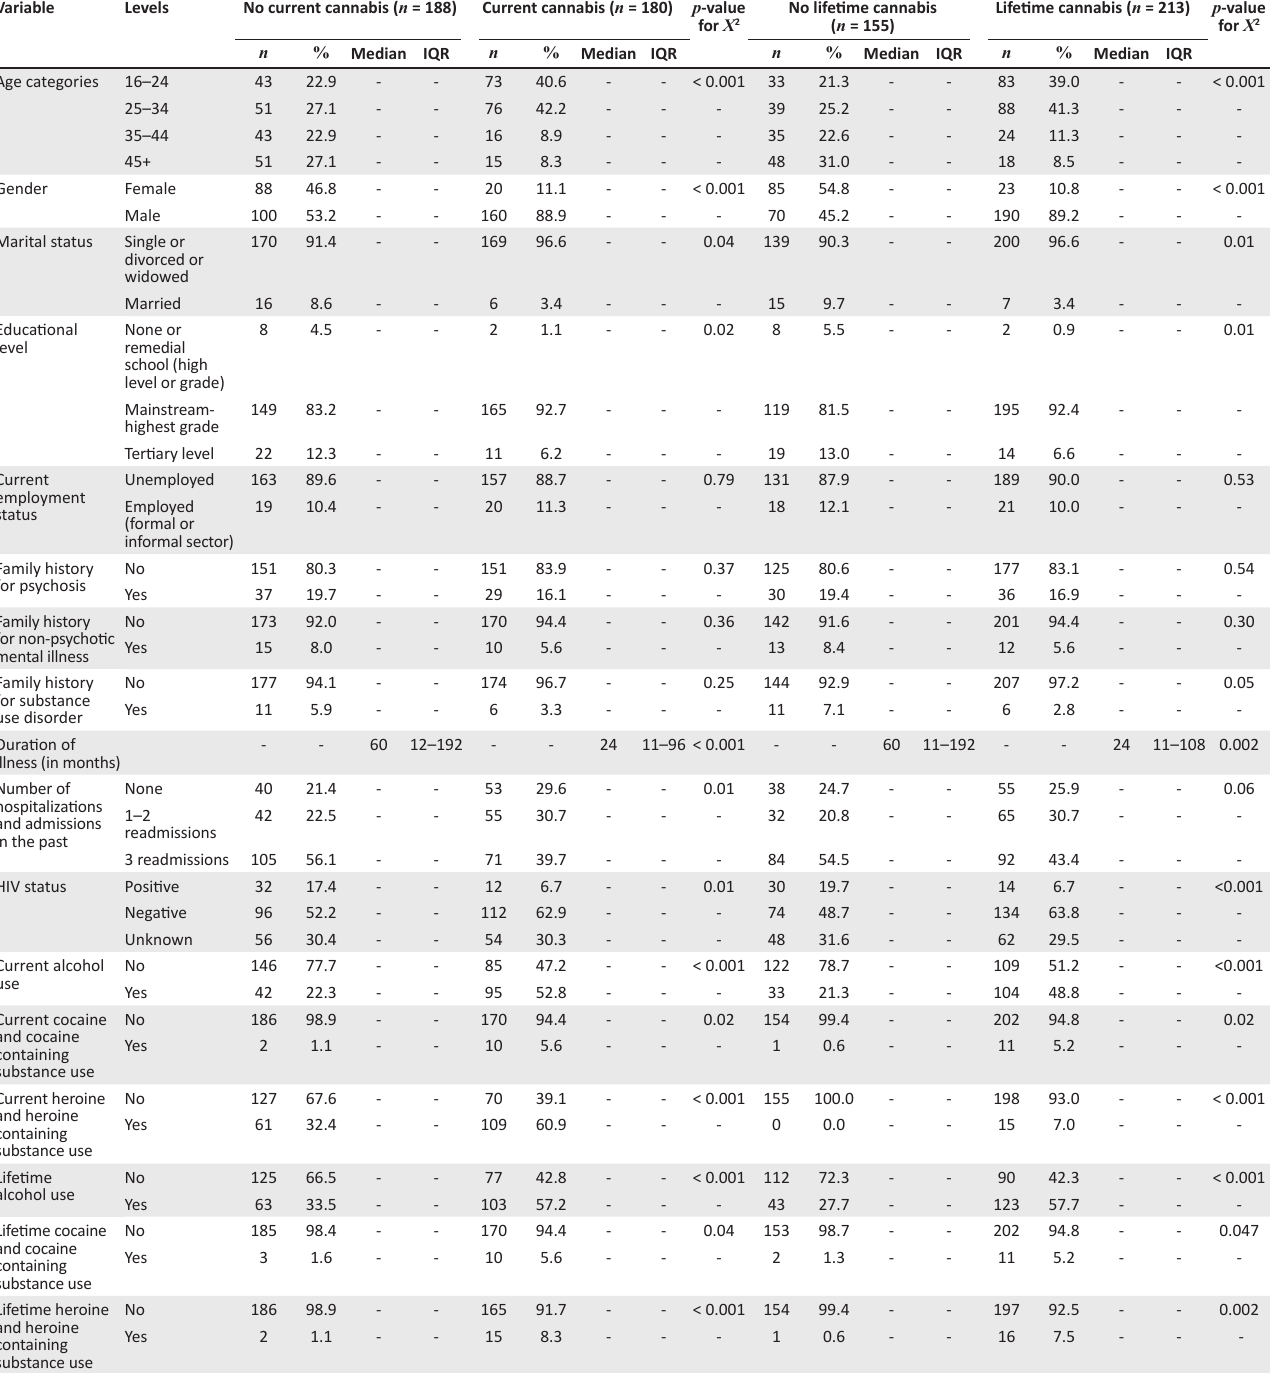
TABLE 2: Association between socio-demographic and clinical variables of people admitted with schizophrenia spectrum and other psychotic disorders and cannabis use. Variable